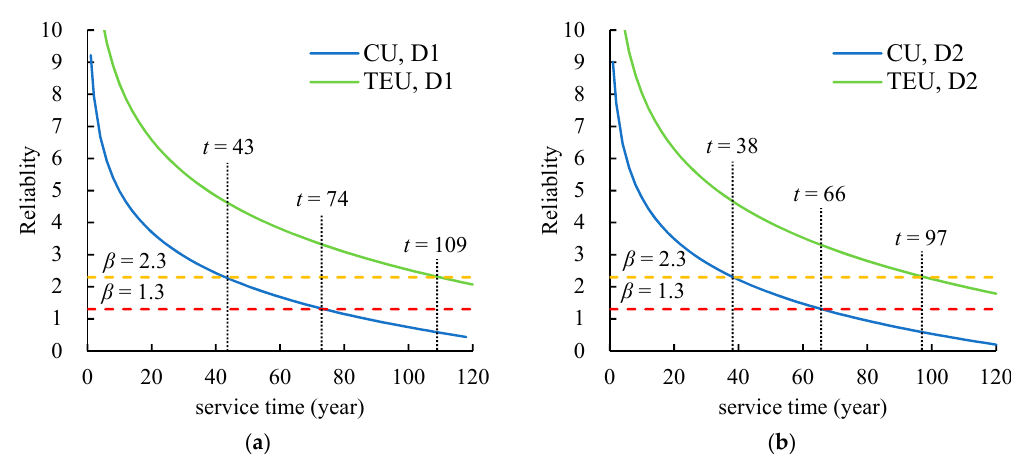
Figure 17. Reliability in terms of hot spot stress: ( a ) critical detail D1 and ( b ) critical detail D2.